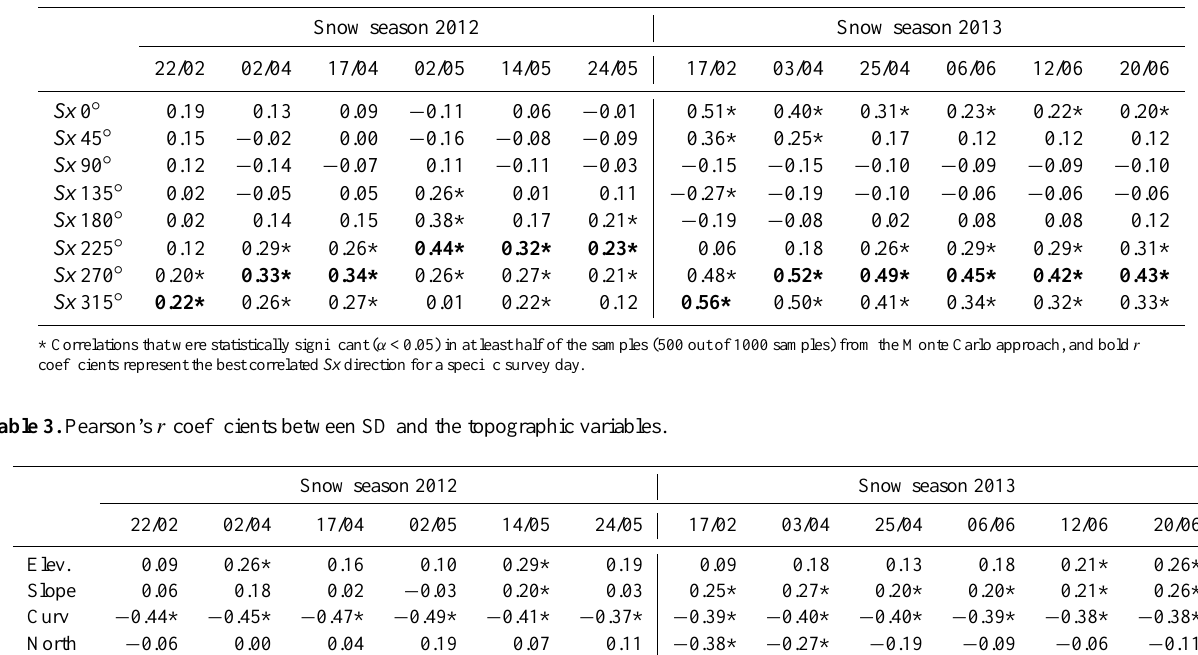
Table 2. Pearson’s r coefficients between SD and Sx , calculated for the eight studied wind directions over the survey days.